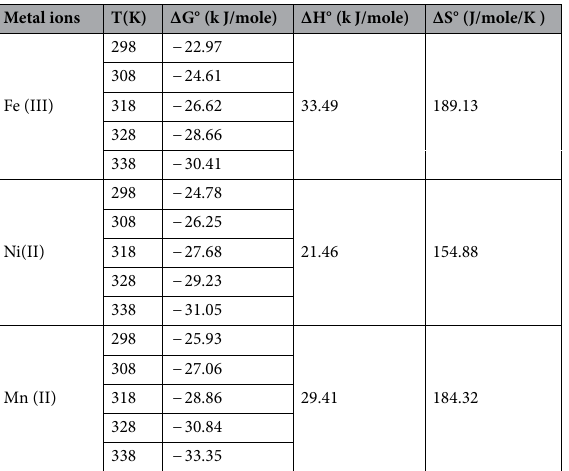
Table 4. Thermodynamic parameters for Fe 3+ , Ni 2+ and Mn 2+ removal from aqueous solution using GO-C